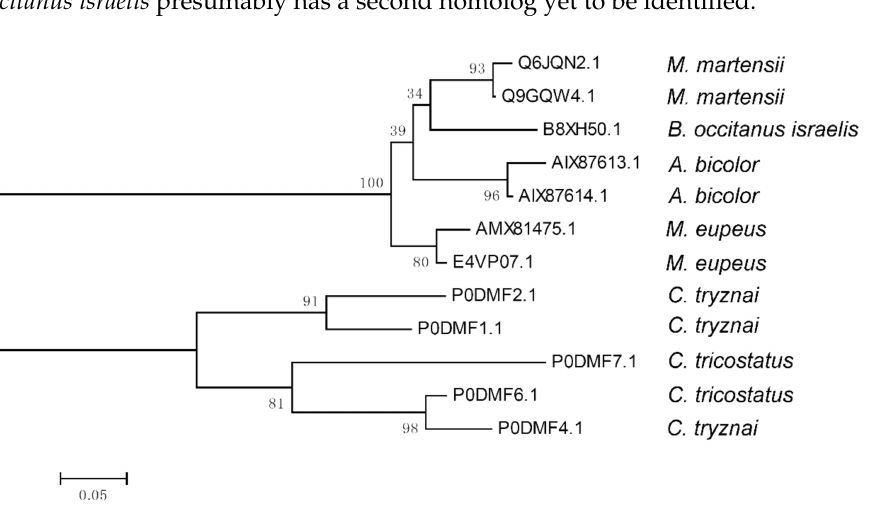
Figure 3. Evolutionary relationship of the scorpion venom peptide Ctri9594 with its homologs. The evolutionary relationship of the scorpion venom peptide Ctri9594 with its homologs was inferred using the neighbor-joining method [19]. The bootstrap consensus tree inferred from 10,000 repli- cates [20] is taken to represent the evolutionary relationship. Evolutionary analyses were conducted in MEGA7